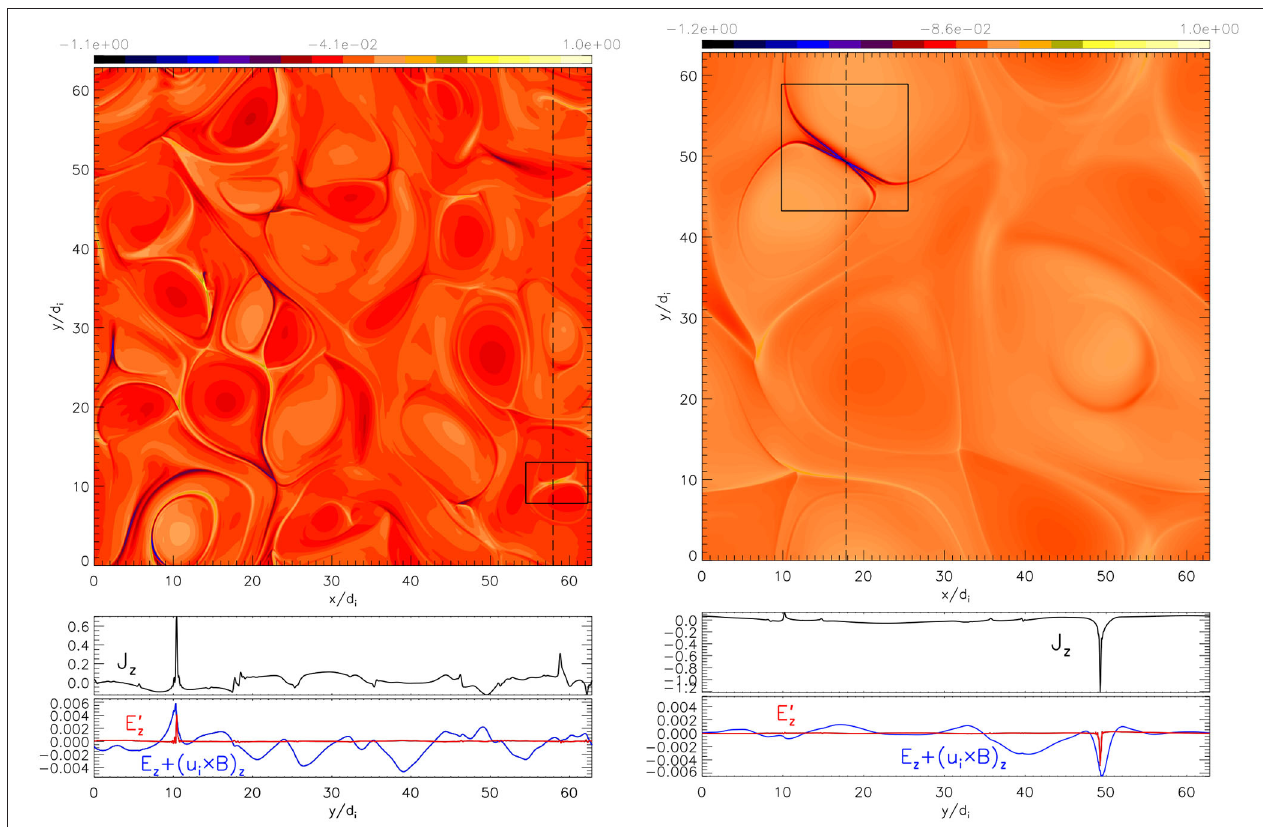
FIGURE 1 | (Left) From sim.A. (top) Shaded iso-contours of the out-of-plane current density J z at t One-dimensional cut along y at x (Right) From sim.B. (top) Shaded iso-contours of the out-of-plane current density J z at t plane has been slightly shifted to highlight the two magnetic islands forming this CS). (bottom) One-dimensional cut along y at x line in the top panel) of J z (black line), E ′ z with respect to the corresponding plot for sim.A because the current peak in sim.B is negative. However, the length of the y -range shown, facilitate a meaningful